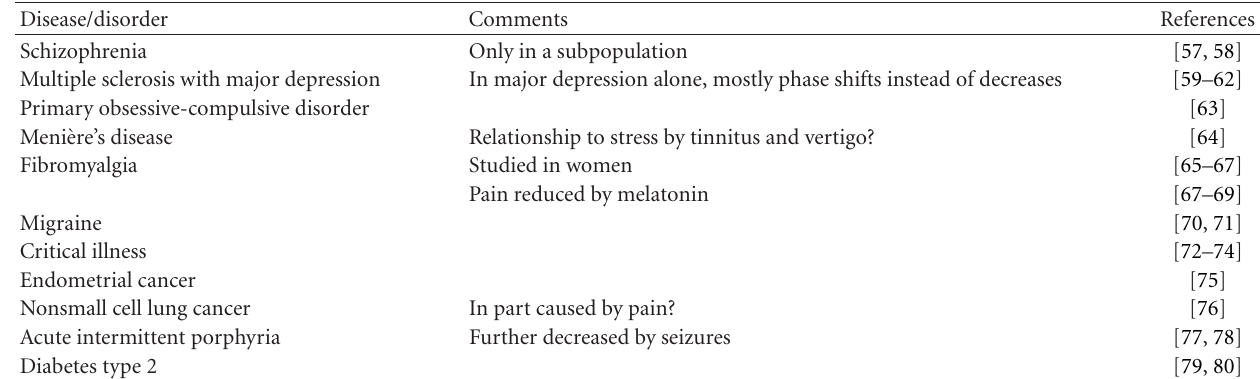
Table 1: Diseases and disorders that cause decreases in human ∗ melatonin secretion independently of apparent tissue destruction in SCN or pineal